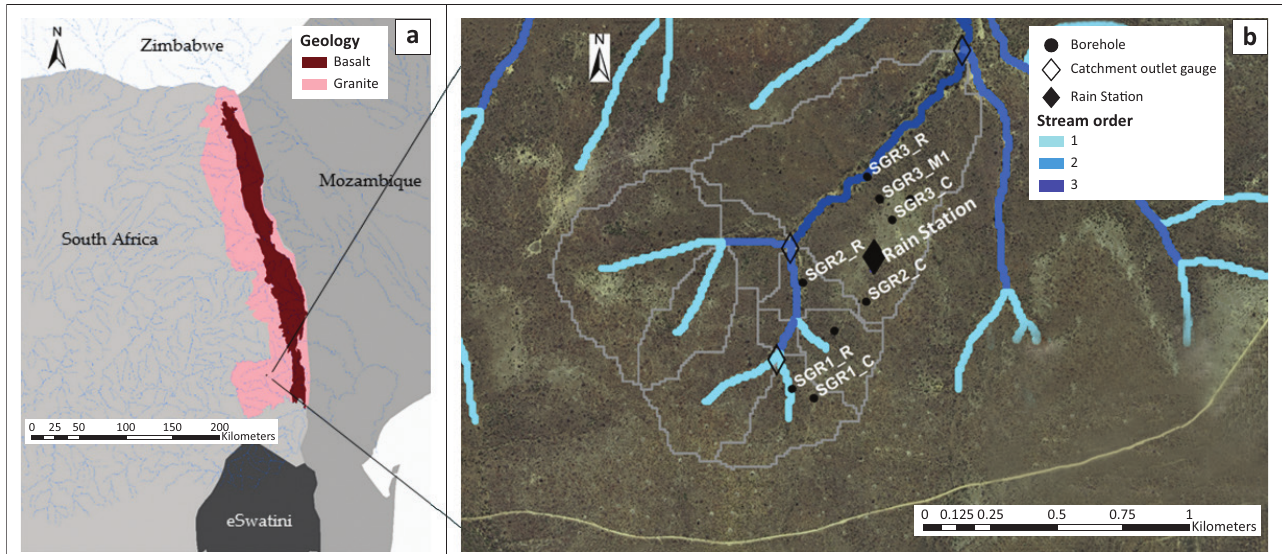
FIGURE 1: (a) Location of the KNP within South Africa’s borders indicating its two main geology formations present and (b) location of Southern Granite Supersite within KNP, including the orientation of the hydrometric network along three stream orders (first, second and third with their associated hillslope catenas and riparian